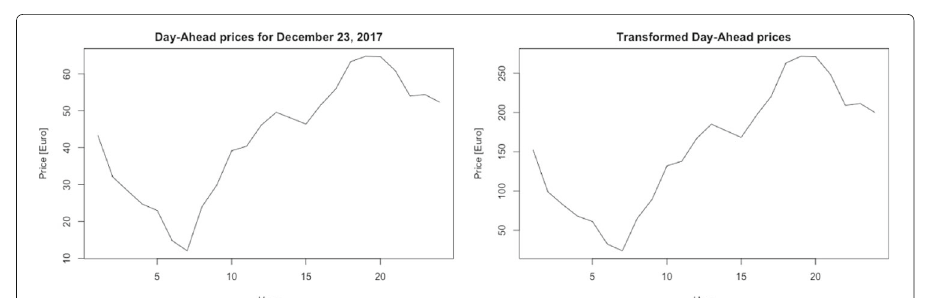
Fig. 4 Day-Ahead prices of December 23, 2018 and transformed time